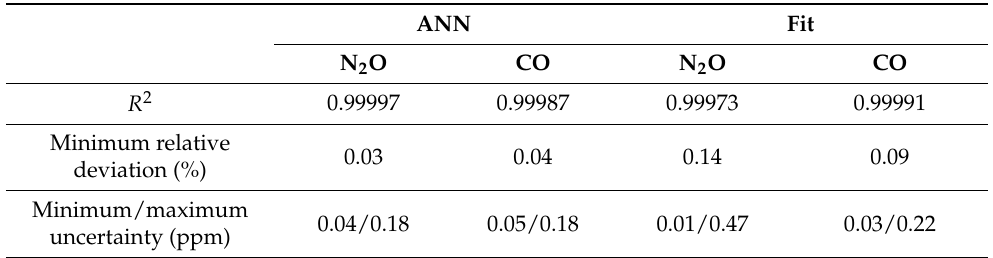
Figure 4. ( a ) Results for the fitted (crosses) and predicted (circles) concentrations for CO and N 2 O. The determined concentrations are corrected by a factor, derived from the difference of the concen- trations of the pure premixtures and the expected value; ( b ) relative deviation of the determined concentrations to the linear fits and uncertainty for the ANN predictions and fit results, given by the standard deviation of the calibrated concentrations for each mixture. Table 3. C oefficients of determination, minimum achieved relative deviations, and minimum and maximum uncertainties resulting from ANN predictions and fits.